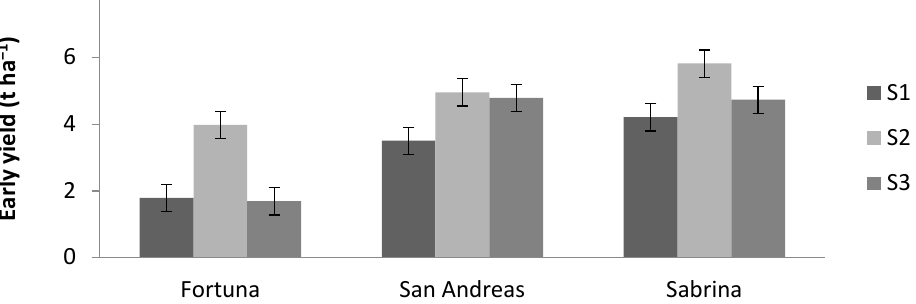
Figure 2. Mean values of early yield for three strawberry cultivars (Fortuna, San Andreas and Sabrina) irrigated with three nutrient solutions. K:N balance: S1 (1.3/2.0), S2 (2.6/1.0), S3 (3.0/0.6) in growth and productive period. Vertical bars indicate LSD value ( p < 0.05).